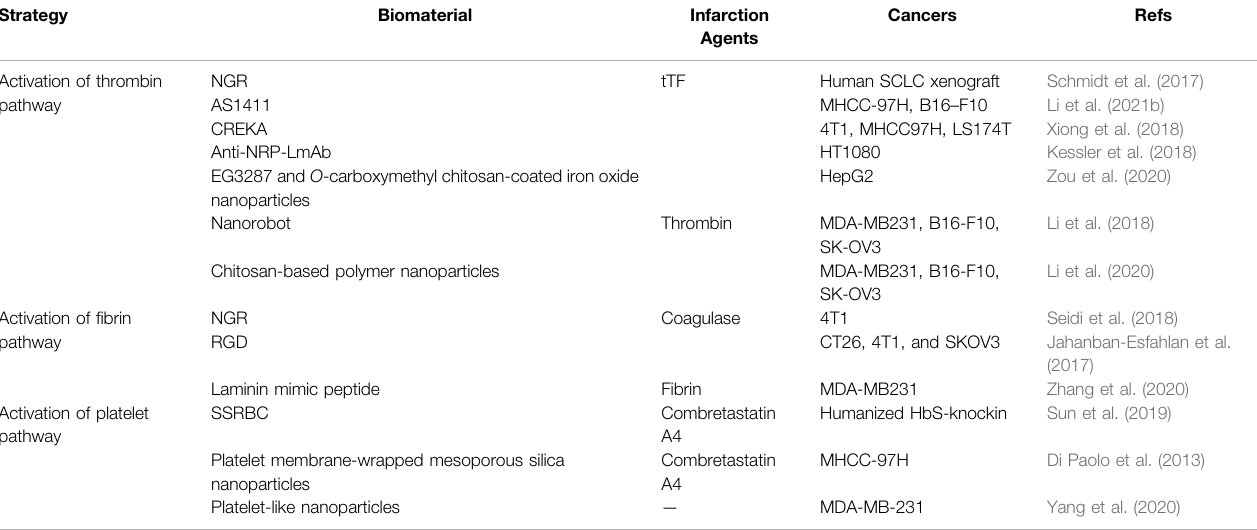
TABLE 1 | Summary of biomaterials for tumor infarction